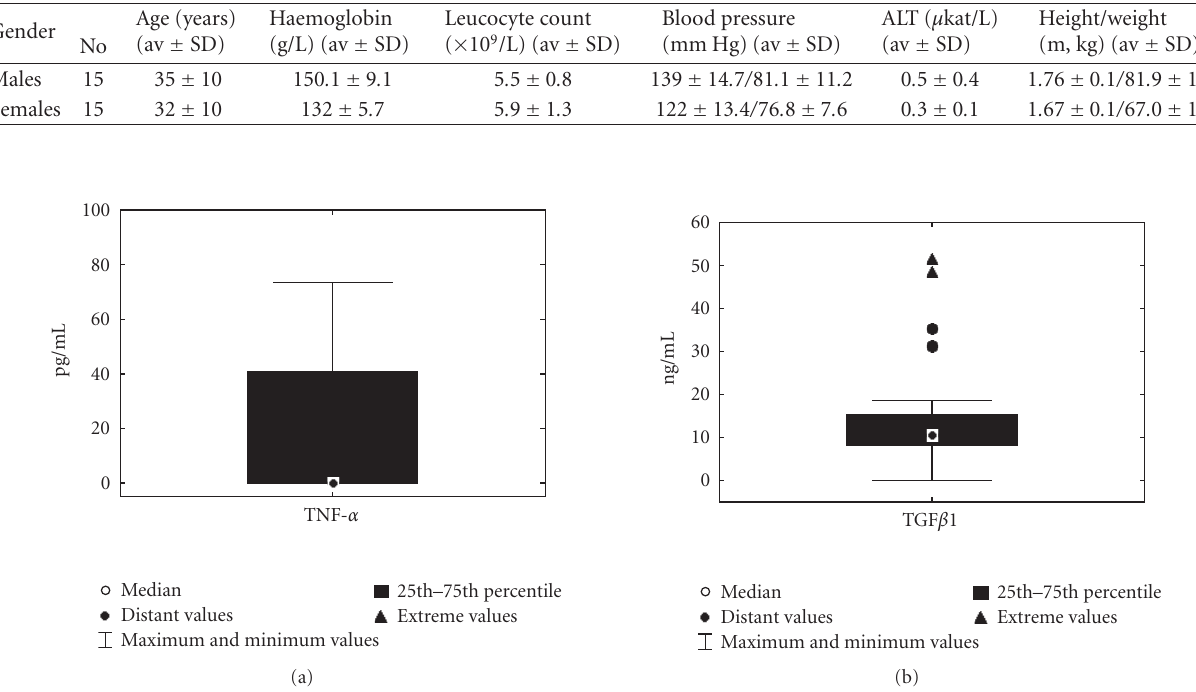
Figure 2: Plasma concentration of tumor necrosis factor- α (TNF- α ) and transforming growth factor β 1 (TGF β 1) in the healthy blood donors (box-and-whiskers plot). See the caption in Figure